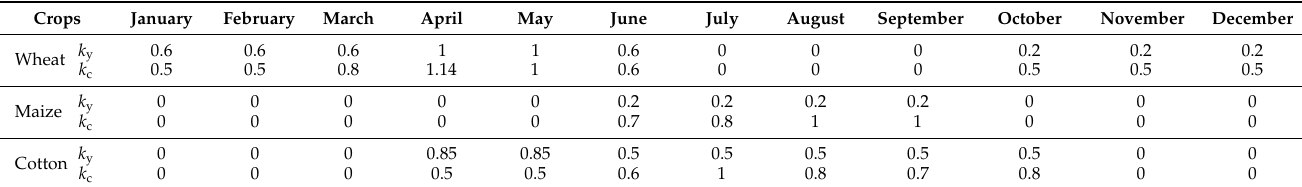
Table 1. Crop yield response factor ( k y ) and crop coefficient ( k c ) of the main crops in different growth periods.